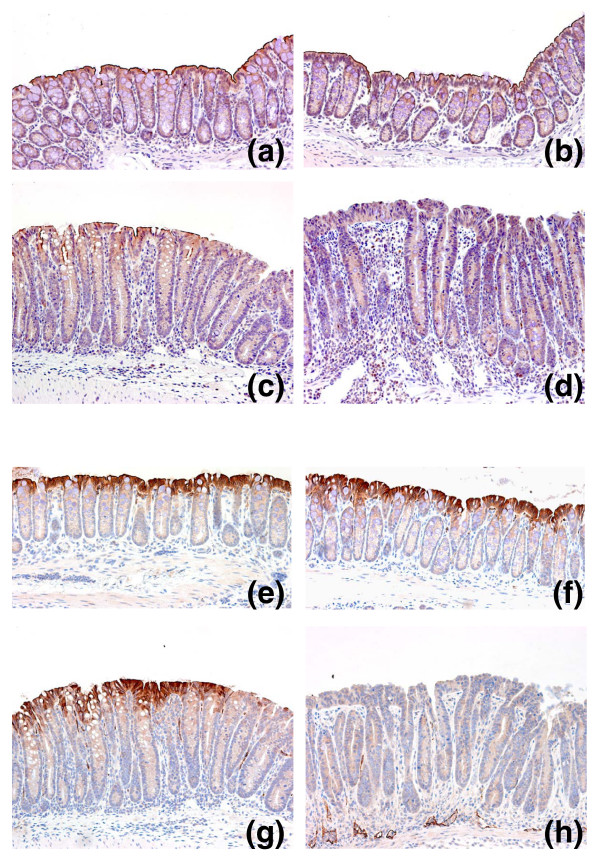
Validation of Dra and CA IV expression by immunohistochemistry. Colonic samples were stained with antibodies against (a-d) Dra or (e-h) CA IV. Normal apical expression of proteins was observed in distal colon from uninoculated SW (a,e) and FVB (b,f) mice. By 9 dpi, partial loss of protein expression was observed in infected SW mice (c,g) compared with complete lack of expression in infected FVB mice (d,h). Original magnifications are 200×.